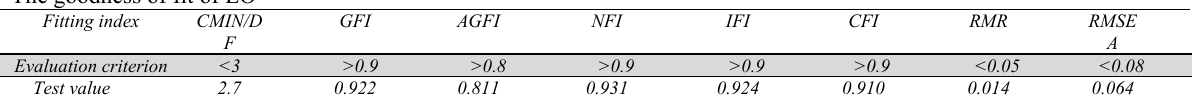
The goodness of fit of